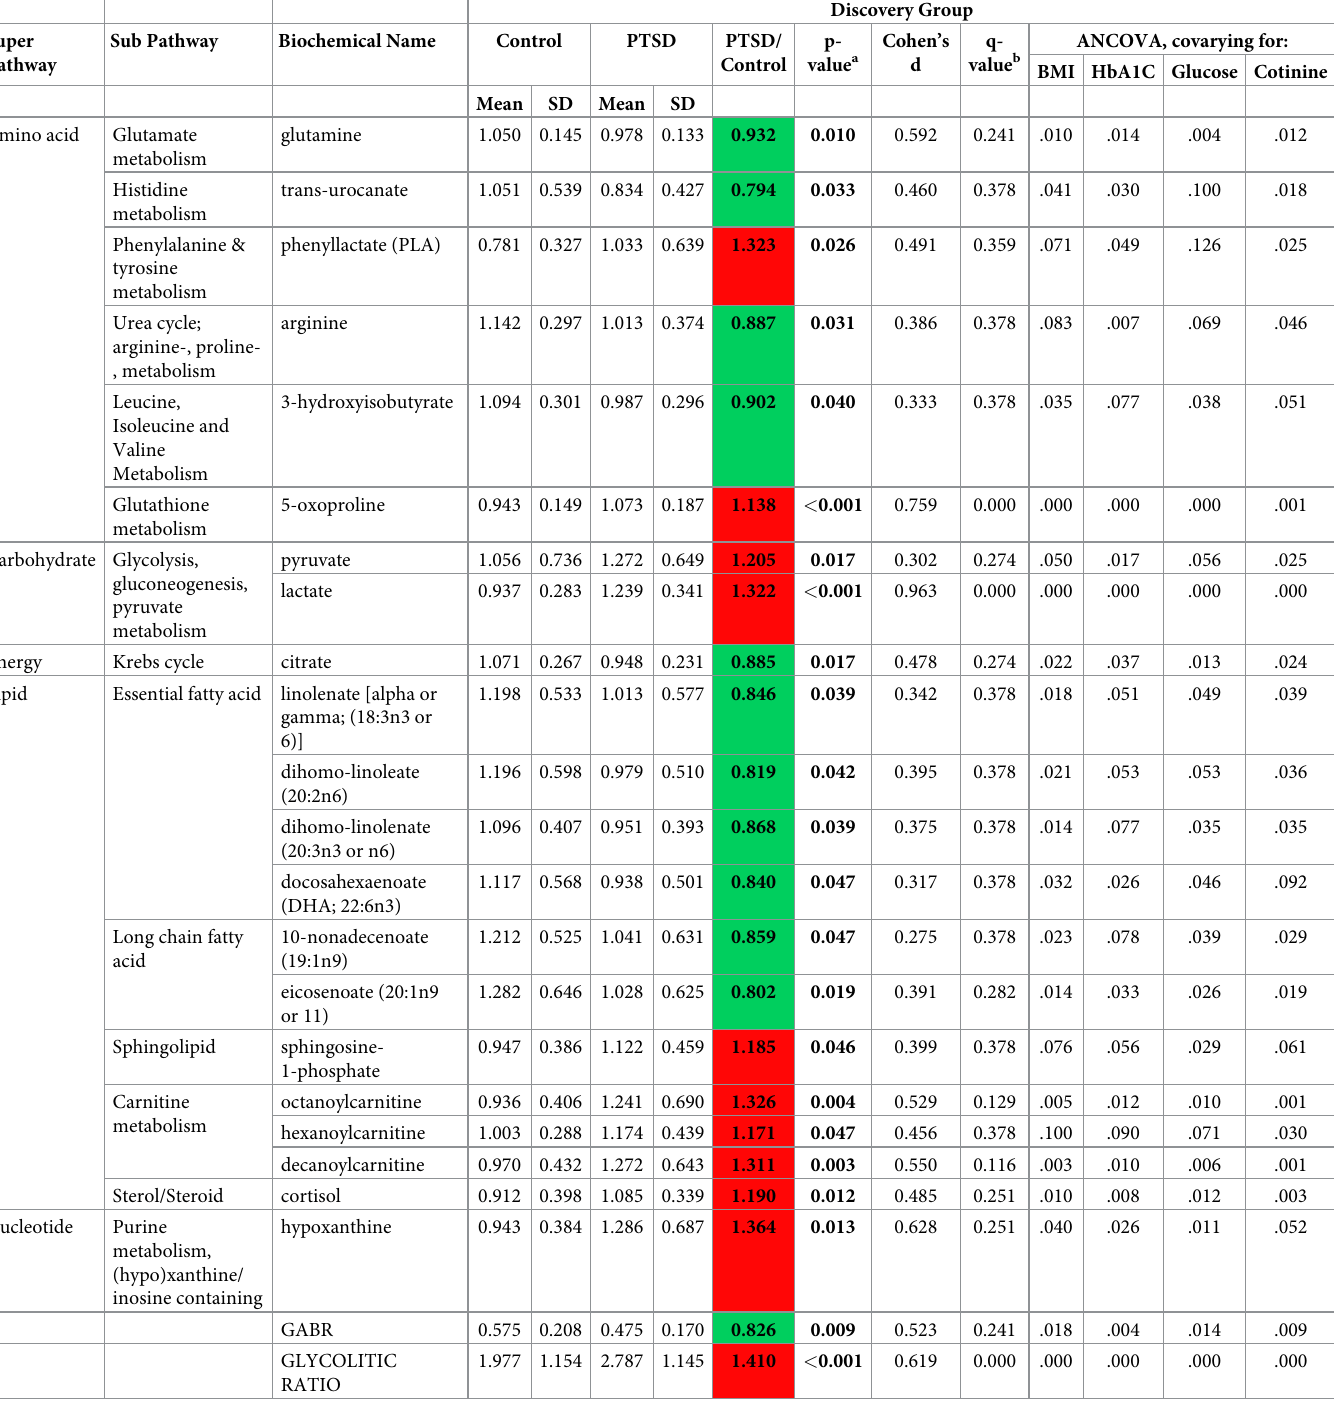
Discovery Group